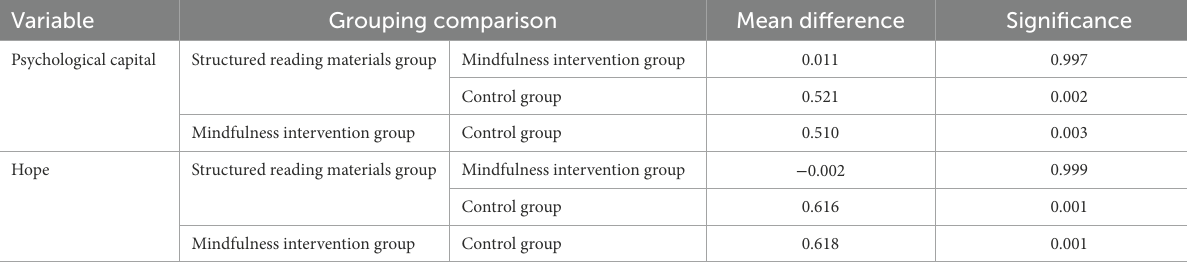
TABLE 8 Post hoc multiple comparisons based on Scheffe method.